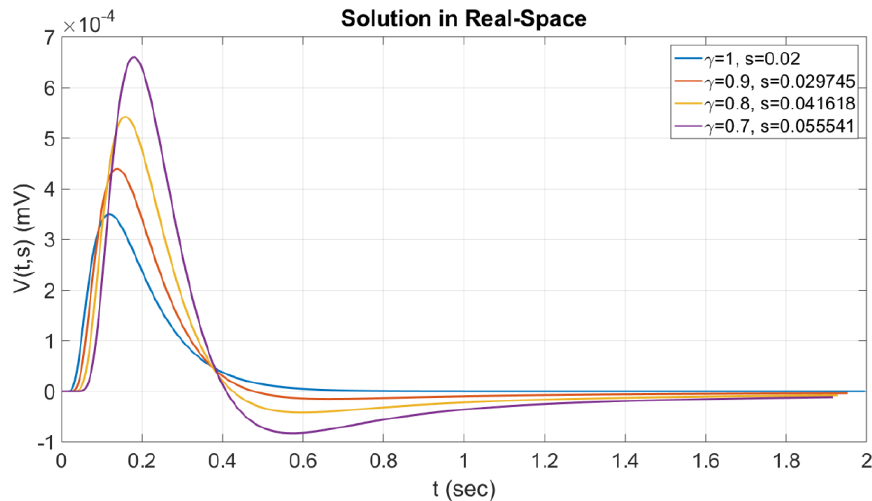
Figure 2. The voltage V(t,s) for various values of fractional order γ and corresponding values of s in real space (S = 0.02).